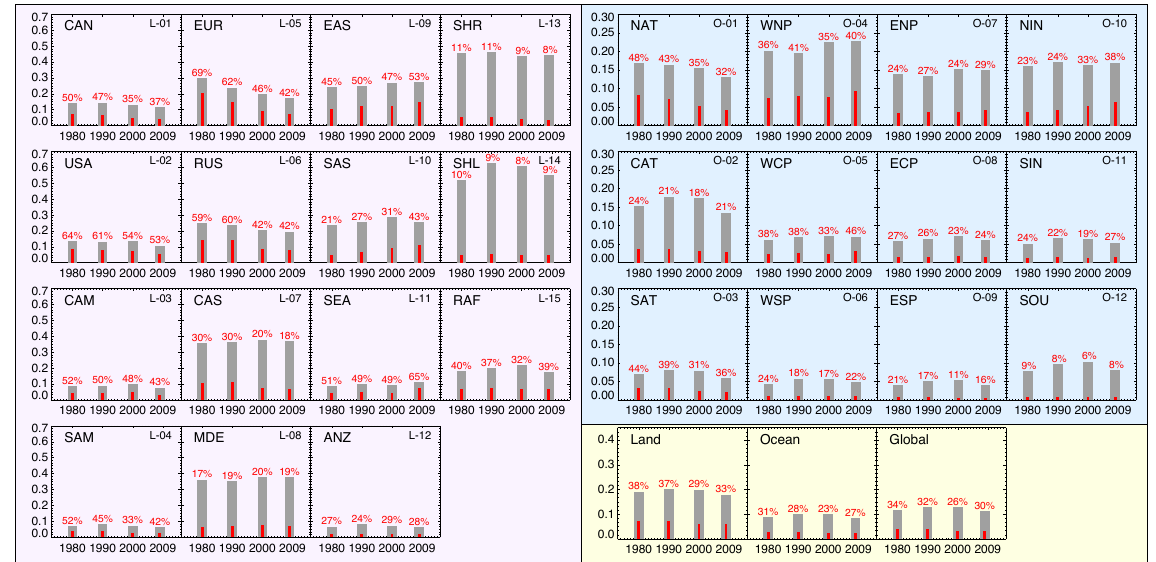
Fig. 15. Model-calculated average AOD (thick grey vertical bars) in decadal time slices, 1980, 1990, 2000, and 2009, over 15 land regions (pink panels, labeled “L-xx” where xx = 01–15), 12 ocean regions (light blue panels, labeled “O-xx” where xx = 01–12), and land, ocean, and global averages (light yellow panels). Region names listed in Table 1. Thin red vertical bars inside of the grey bars indicating the AOD from combustion (fossil fuel, biofuel, and biomass burning, or FF + BB) sources, with the number of percentage AOD from FF + BB shown in red color above each corresponding AOD